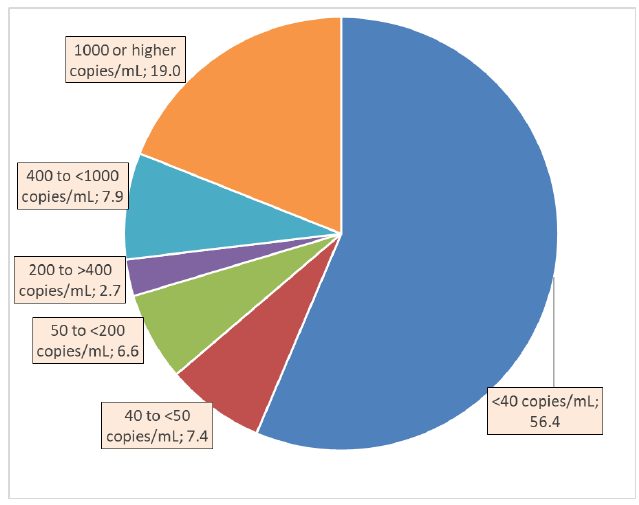
Figure 1. Percent distribution of persons on antiretroviral therapy by viral load levels in HIV/AIDS clinics of Haut-Katanga and Kinshasa provinces, Democratic Republic of Congo,